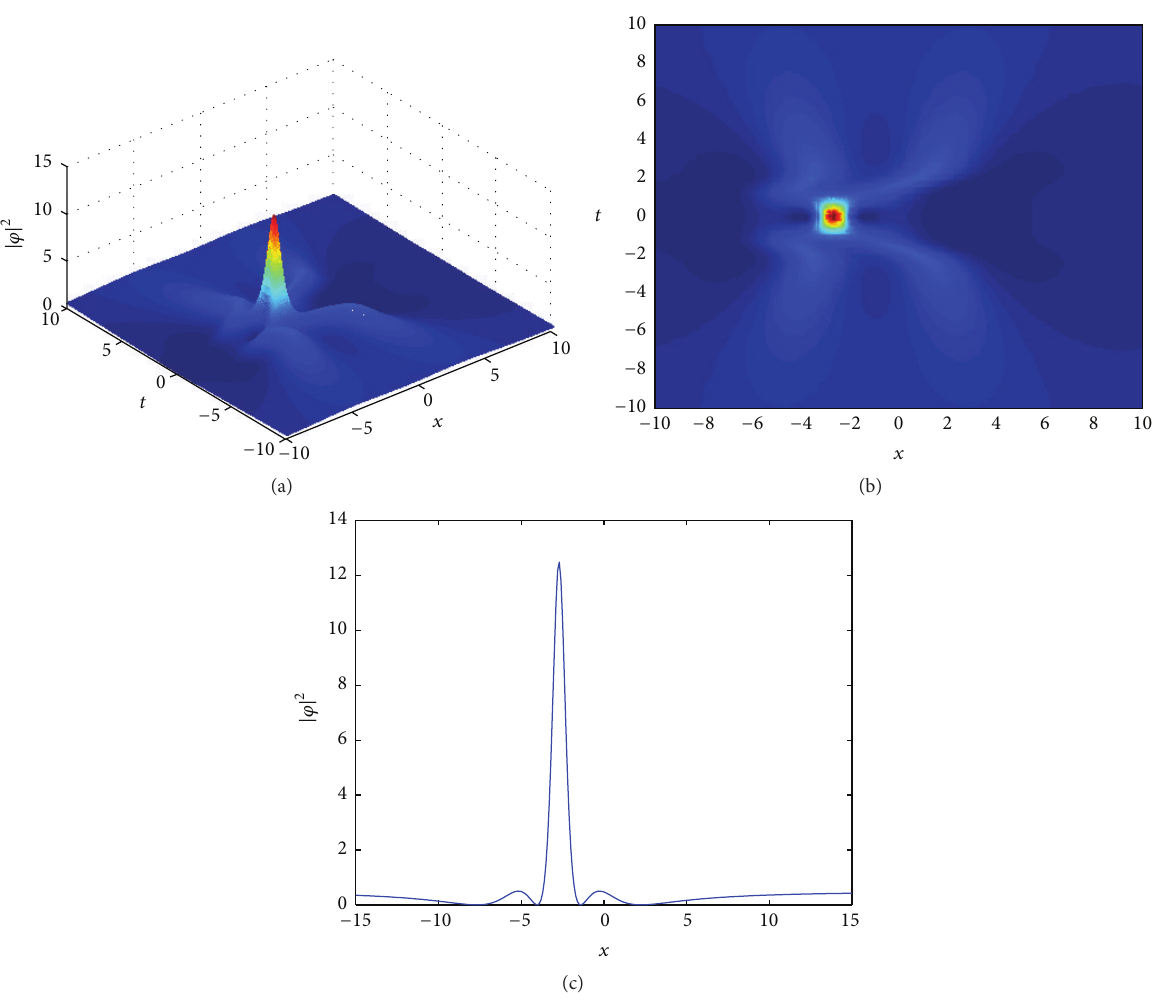
Figure 7: (a) The second-order rogue wave propagations for the intensity |𝜑| 2 . (b) Contour plot with the gravity field 𝑏 = 0.5 , 𝛽(𝑡) = 0.5 exp ( sech (0.2𝑡 3 )) . (c) Rogue wave propagations for the intensity |𝜑(𝑥,0)| 2 with 𝑡 = 0 .